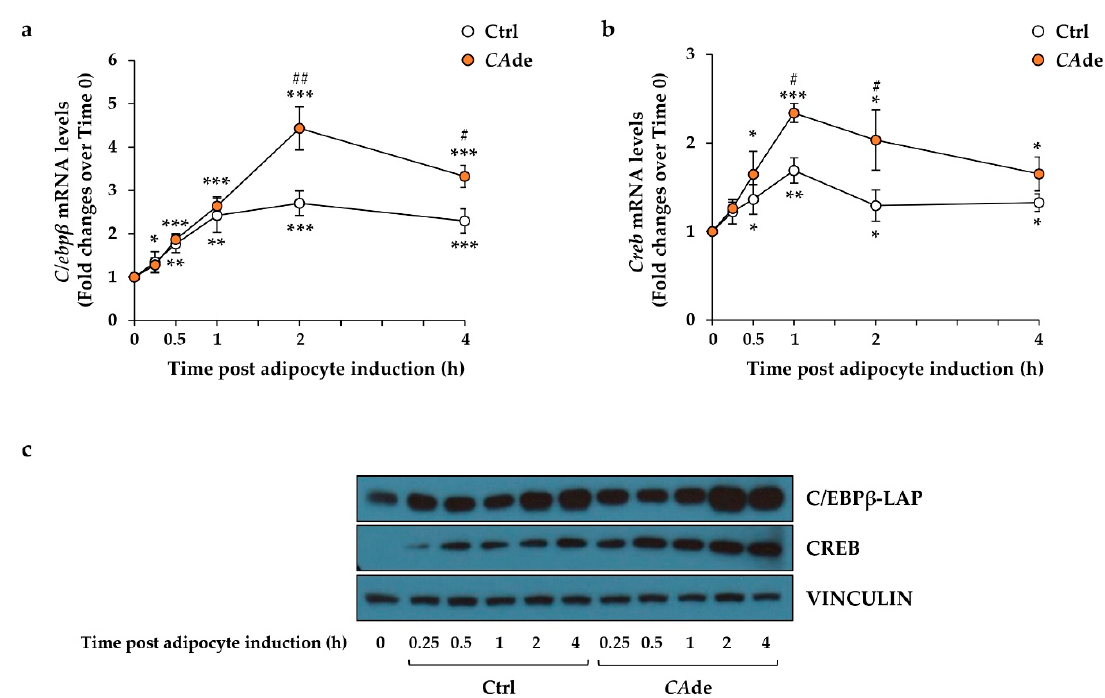
Figure 2. E ff ect of CA de on the expression of the miR-155 target genes, CCAAT / enhancer-binding protein beta ( C / Ebp β ) and cyclic Adenosine Monophosphate (cAMP) response element-binding protein ( Creb ), during the early stage of adipogenesis in 3T3-L1 cells. 3T3-L1 pre-adipocytes were cultured for 0.25, 0.5, 1, 2, and 4 h with AS (Ctrl) or AS + CA de (100 µ g / mL). The C / Ebp β and Creb levels were evaluated by quantitative real-time PCR. Time course of C / Ebp β ( a ) and Creb ( b ) levels in Ctrl and CA de-treated cells relative to untreated 3T3-L1 cells at time 0. Values are means ± SEM of three independent experiments. Control value at time 0 was set as 1.00. Statistical significances among groups were tested by one-way ANOVA followed by Bonferroni correction post-hoc test (* p < 0.05, ** p < 0.01, and *** p < 0.001 vs. untreated 3T3-L1 cells at time 0; # p < 0.05 and ## p < 0.01 vs. control 3T3-L1 cells). ( c ) Representative Western blots of the total form of the C / Ebp β -liver-enriched activating protein (LAP), CREB , and VINCULIN proteins in control cells and CA de-treated cells at 0.25, 0.5, 1, 2, and 4 h after adipogenic induction. C / Ebp β -LAP and CREB protein expression levels at the basal (0) are also reported.